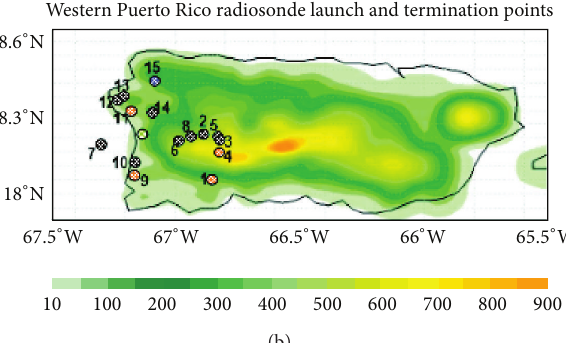
Figure 3: RAMS simulation setup flow chart for PSD ingestion. days selected for simulation. For grid 2, an explicit cloud microphysics scheme [19] is used.